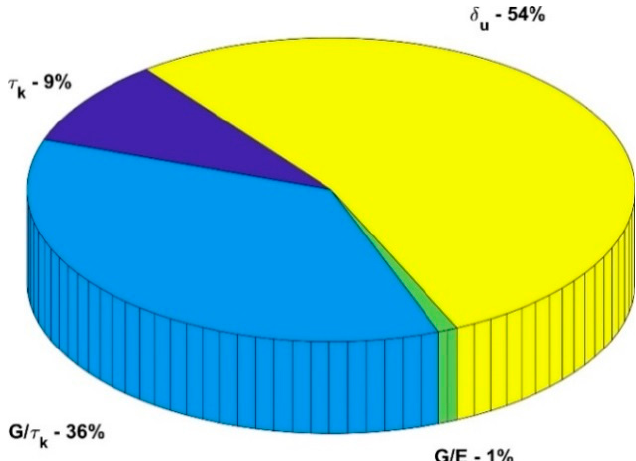
Figure 12. Mean values of Sobol sensitivities in the investigated buildings.